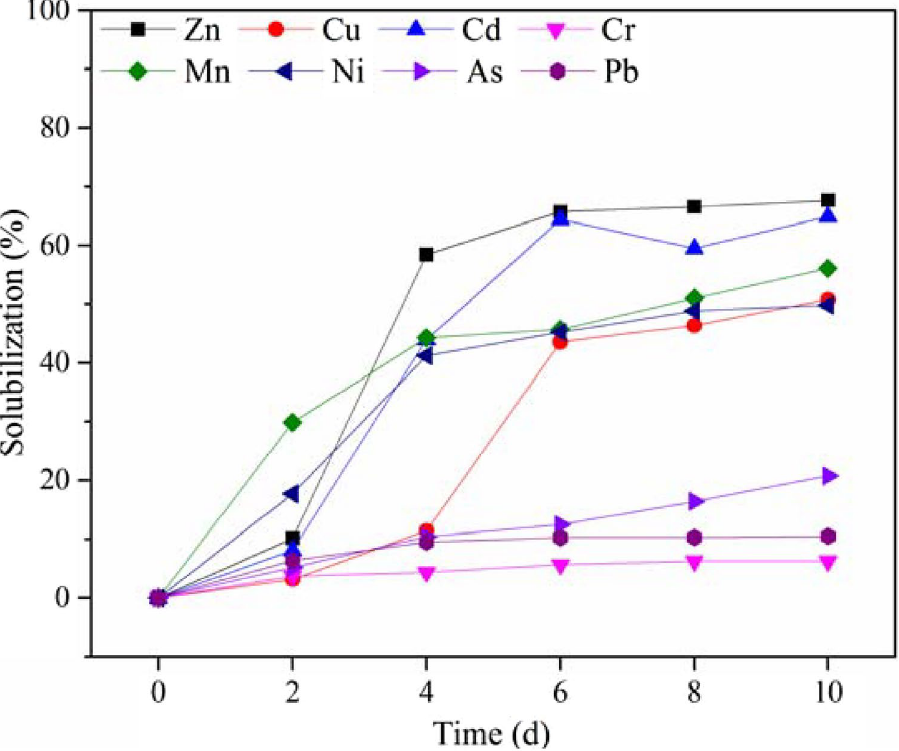
Figure 2. Removal of heavy metals during bioleaching process.